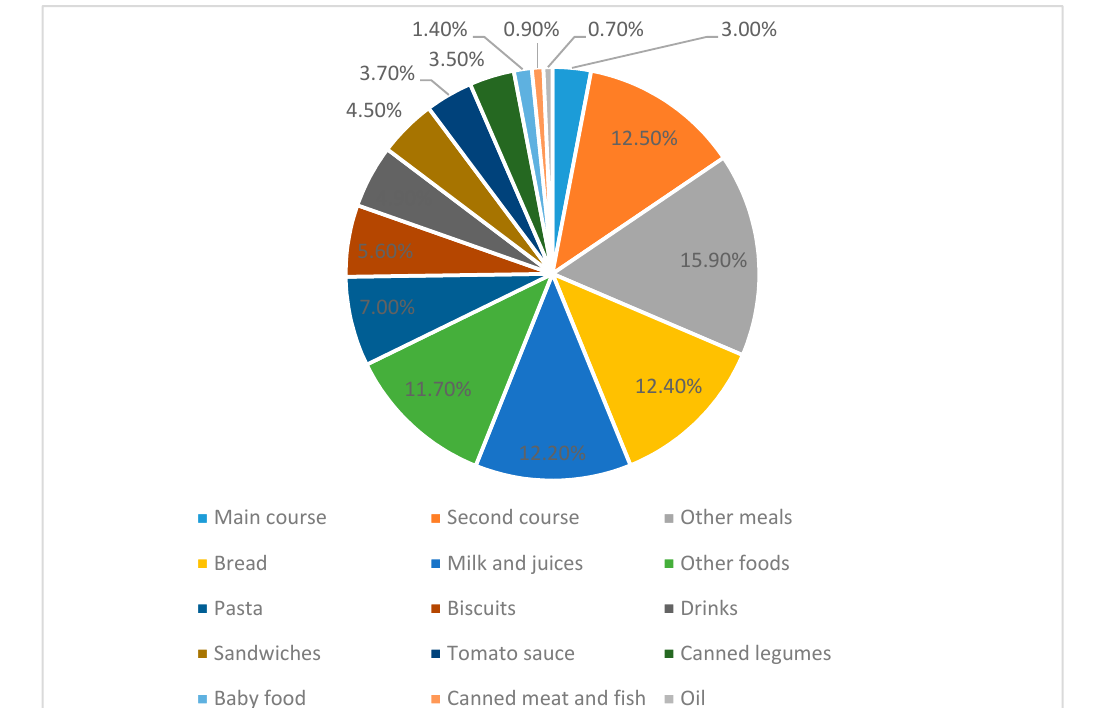
Figure 2. Food donations at 30 June 2020, Magazzini Sociali, Potenza (IT).